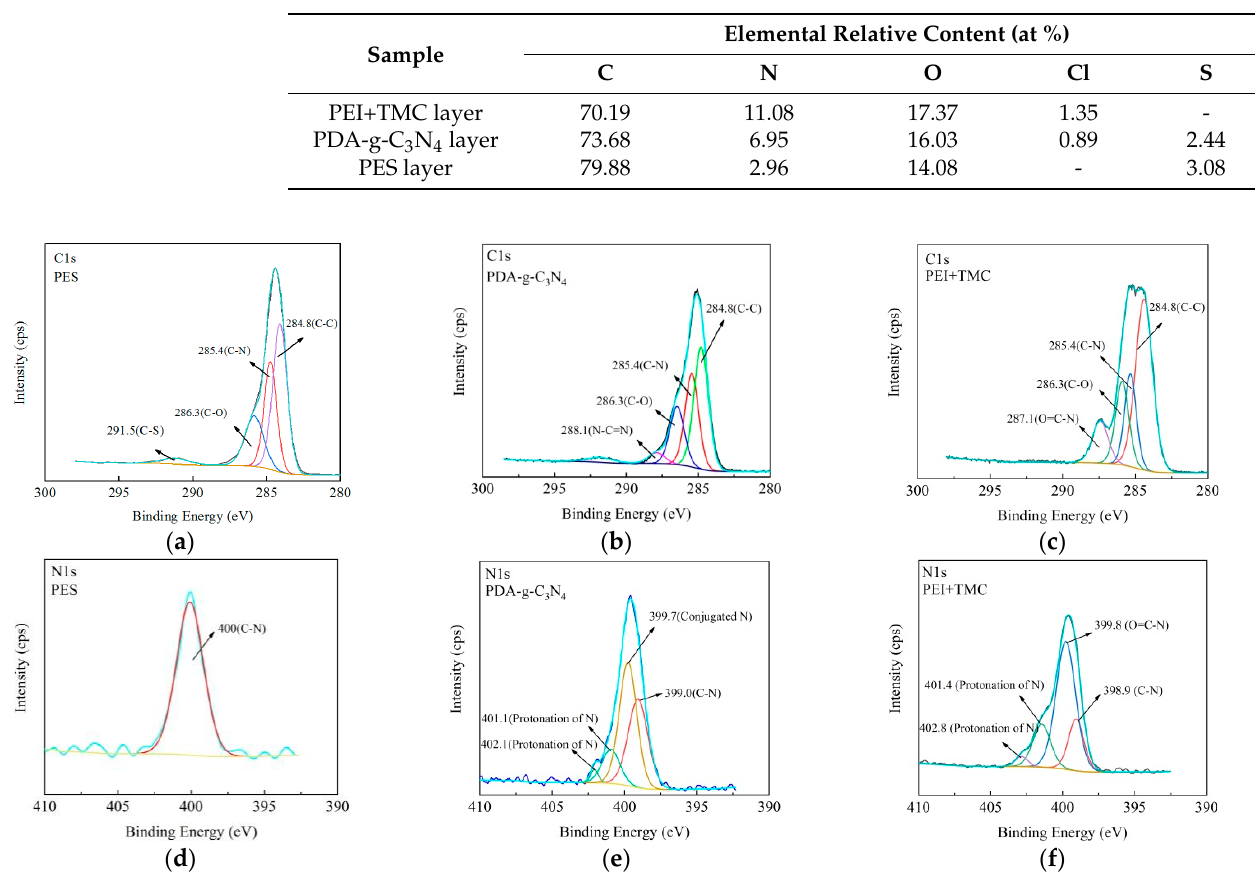
Figure 3. FTIR spectra of M0, M1, M2, M3, M4, and M5 membranes ( a ) and the in situ XPS spectra of the M5 membrane ( b ). Table 3. Relative elemental content in different layers of M5 membrane (from XPS).